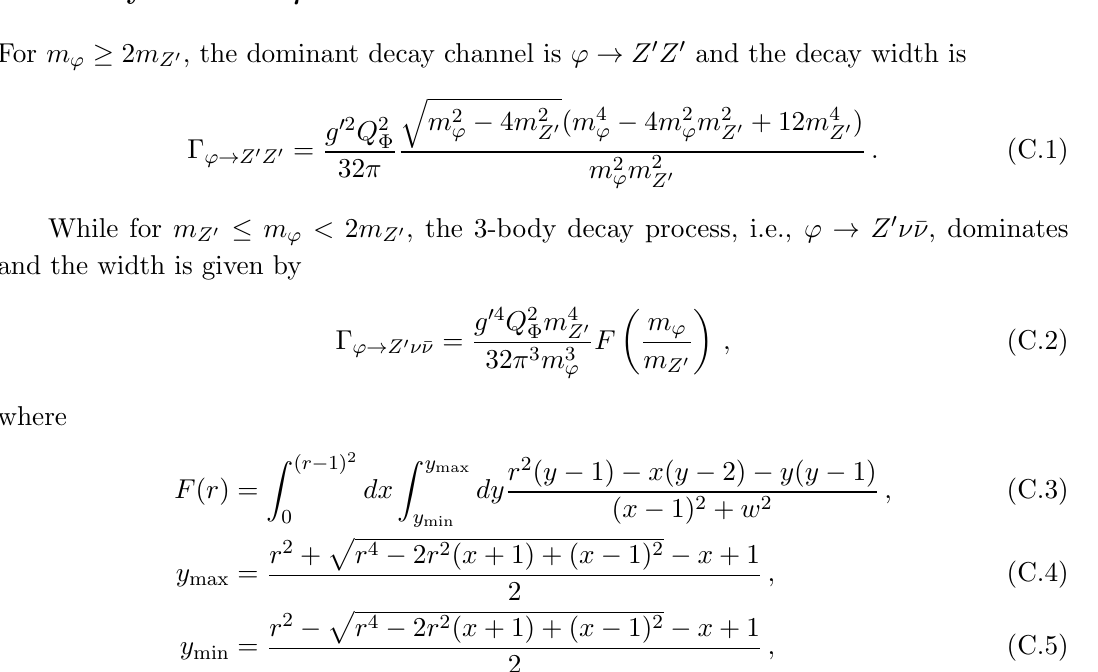
6 (solid) and 0 10 (cid:0) (cid:2) (black dashed). Right: 0